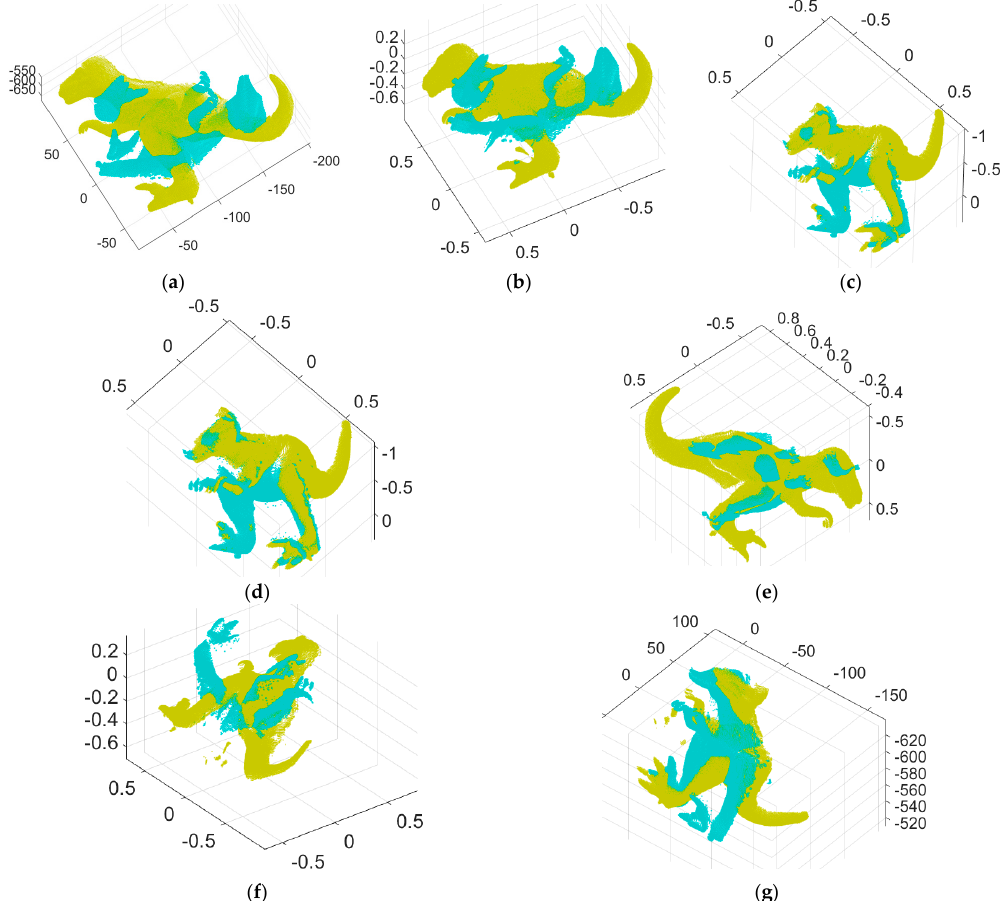
Figure 4. 3D registration results for the dense registration algorithms: ( a ) range images aligned by ICP [7] for Figure 2a,b, ( b ) range images aligned by globally optimal (Go)-ICP [24], ( c – f ) range images aligned by trimmed Go-ICP, with respective trimming percentages of 20%, 30%, 50%, and 80%, ( g ) registration result by fast global registration [31].